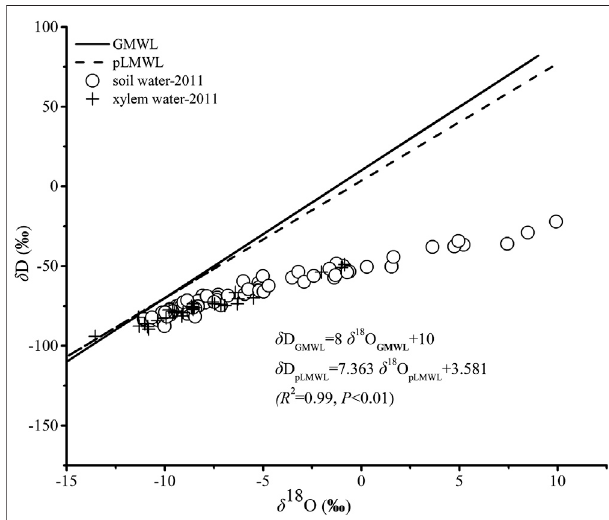
FIGURE 3 | Relationship between δ D and δ 18 O in soil water and xylem water. The Global Meteoric Water Line (GMWL) and the predicted Local Meteoric Water Line (pLMWL) were also presented.